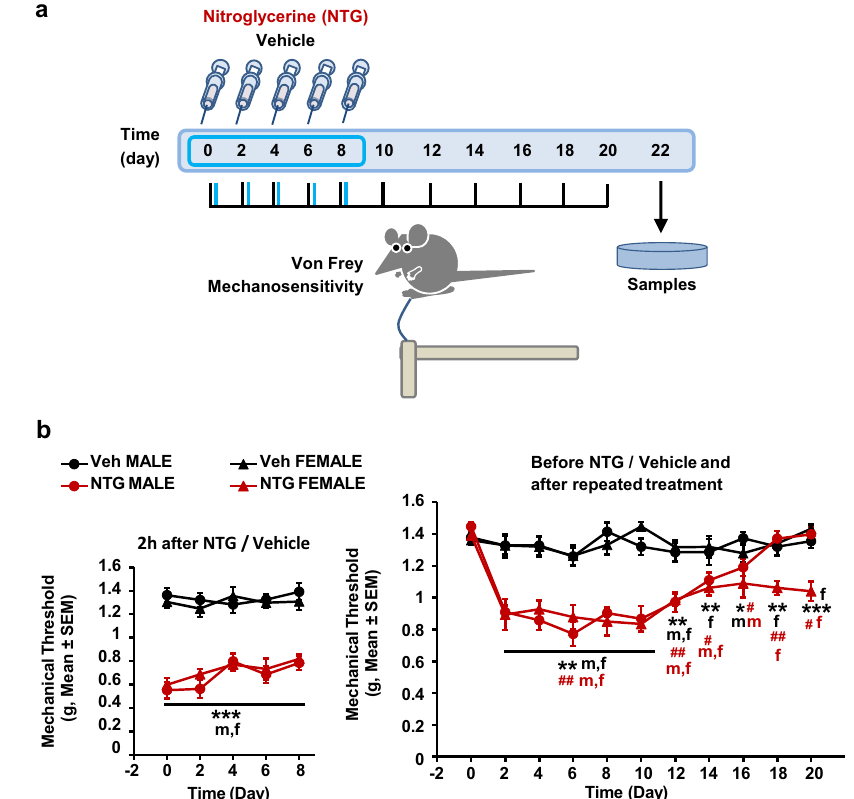
Fig. 1 | Chronic nitroglycerin administration induces generalized long-lasting mechanical hypersensitivity in male and female mice. a Model of chronic migraine induced by fi ve intraperitoneal injections of 10mg/kg nitroglycerin or its vehicle administered every other day (days 0, 2, 4, 6 and 8). Hind paw mechanical sensitivity was assessed with von Frey fi laments 2h after nitroglycerin administra- tion (blue lines), before nitroglycerin injections and after the end of the treatments on days 10, 12, 14, 16, 18 and 20 (black lines). Tissue samples were obtained at the end. b Leftpanels.Nitroglycerin(red)inducessimilaracutehypersensitivityinmales